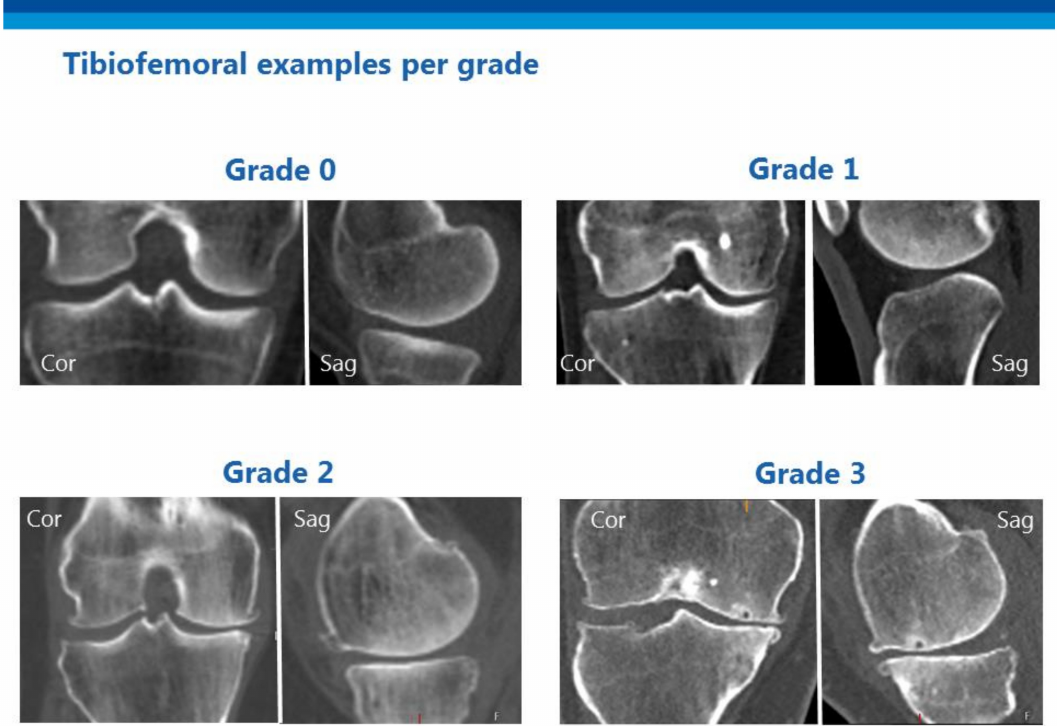
Figure 2. Example images from the atlas showing different grades of tibiofemoral